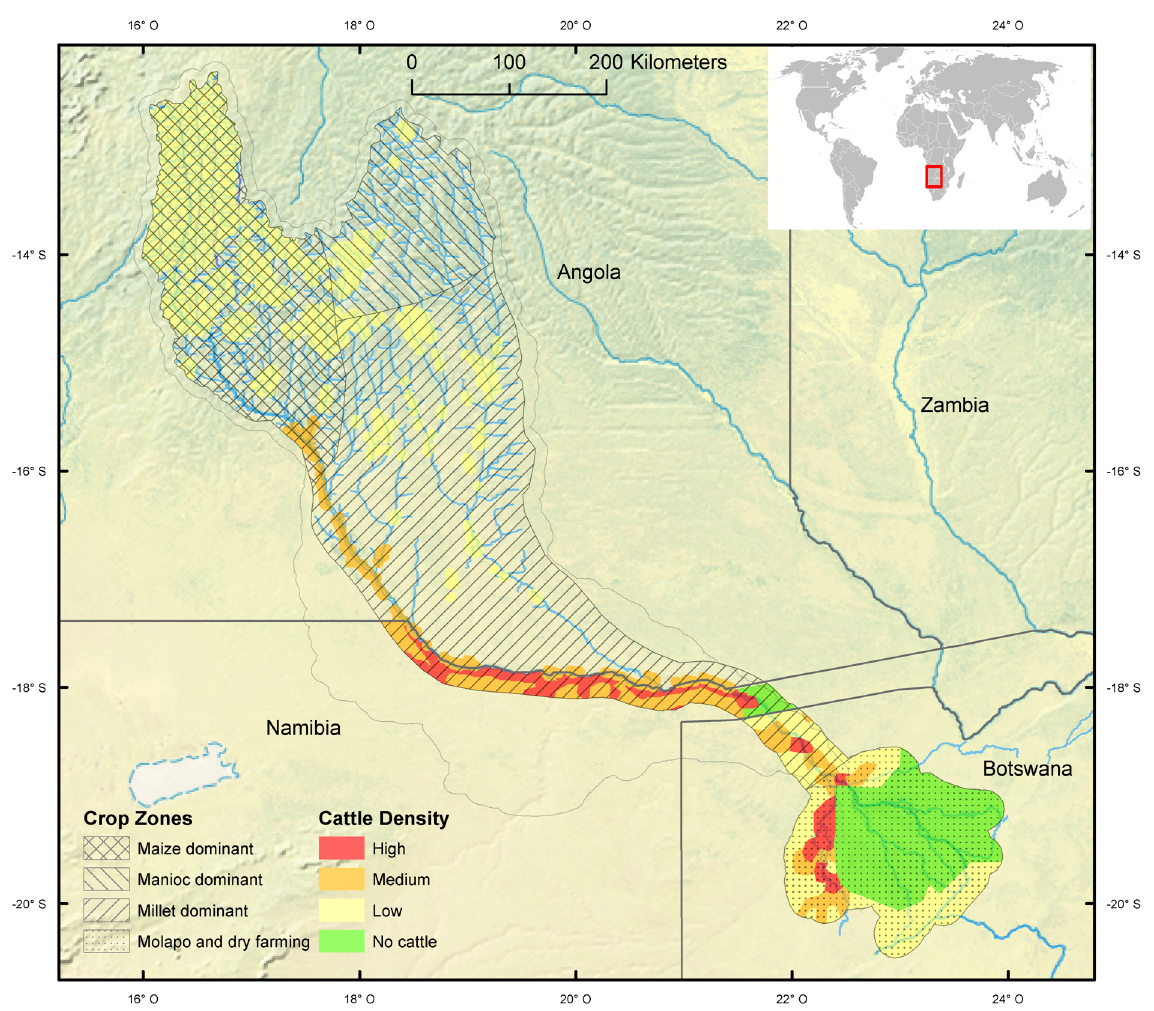
Figure 2. Farming and livestock density in the Okavango Catchment (own representation based on data from